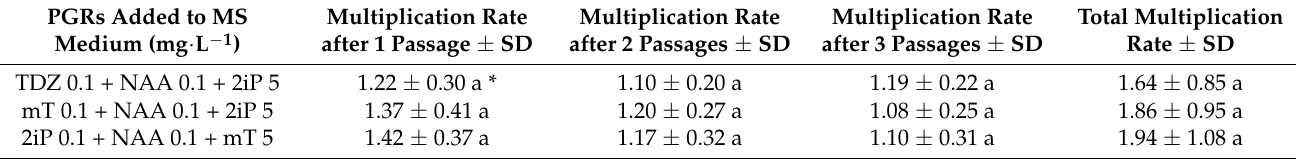
Table 2. Effects of selected plant growth regulators (PGRs) on in vitro shoot multiplication of the tulip cultivar ‘Heart of Warsaw’—second